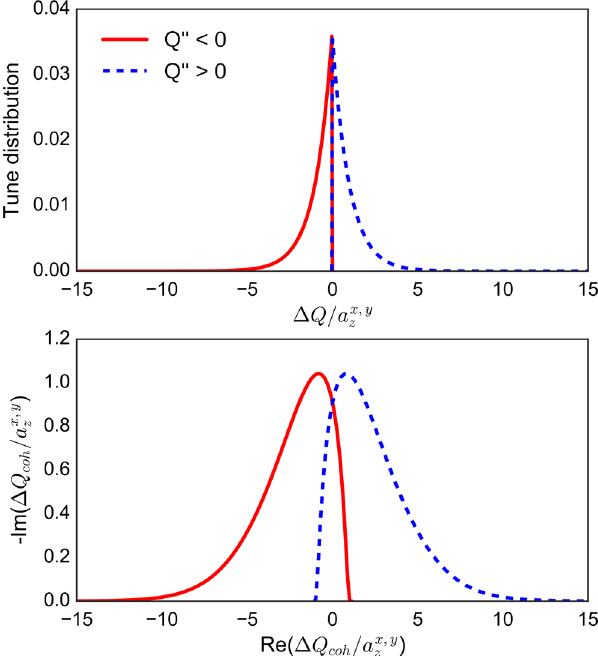
FIG. 1. Incoherent tune distributions (top) and normalized stability diagrams (bottom) for detuning with the longitudinal amplitude from Q 00 < 0 (red, solid line) or Q 00 > 0 (blue, dashed line), respectively, computed employing the formalism described in Ref.